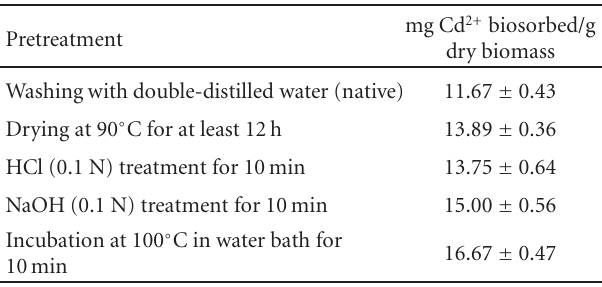
Figure 3: Temprature-dependency profile of Cd(II) uptakes by dried biomass at initial concentration of 10ppm; pH 7.